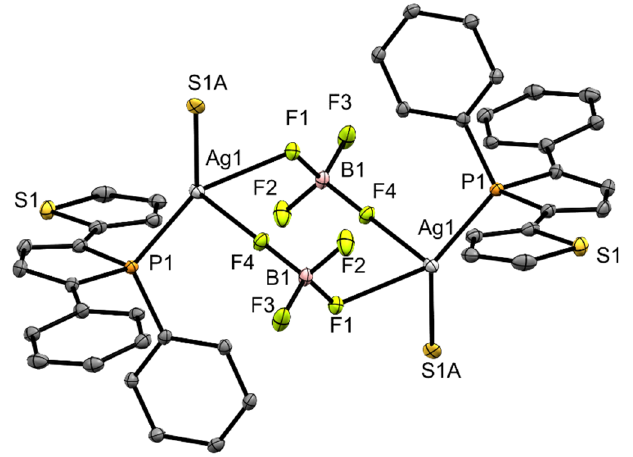
Figure 3. Ortep plots of the molecular structure of 4 in the solid state with ellipsoids drawn at the 30% probability level. Labels for some selected atoms, disorders and hydrogen atoms are omitted for clarity. Important bond lengths and angles: (C4)–(C9) 1.462(6) Å, (C1)–(C5) 1.458(7) Å, (C1)-(C2)